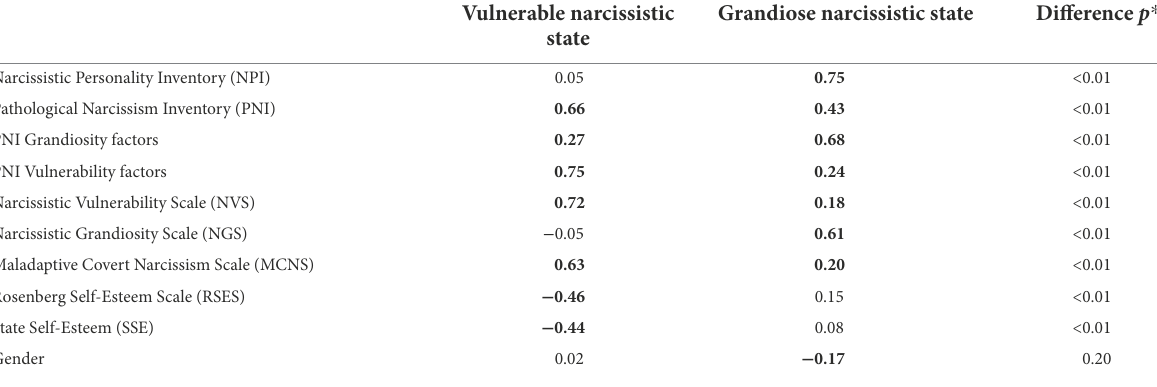
TABLE 4 Associations of the PNI-S in Sample 1: confirmatory factor analysis with